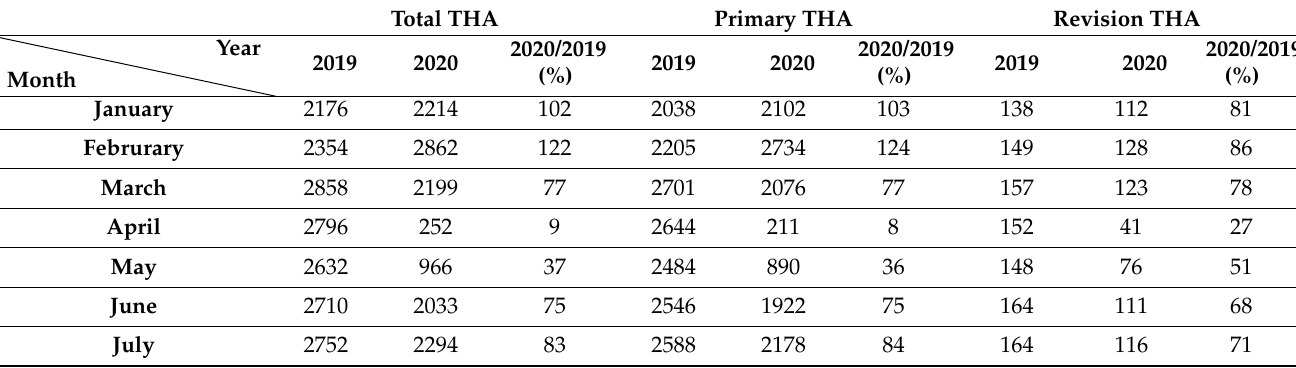
Figure 4. Number of revision total hip arthroplasties (THA) performed in the particular months of 2019 and 2020 in Poland. Table 4. Number of total hip arthroplasties (THA) performed in the particular months of 2019 and 2020 in Poland. Total THA Primary THA Revision THA